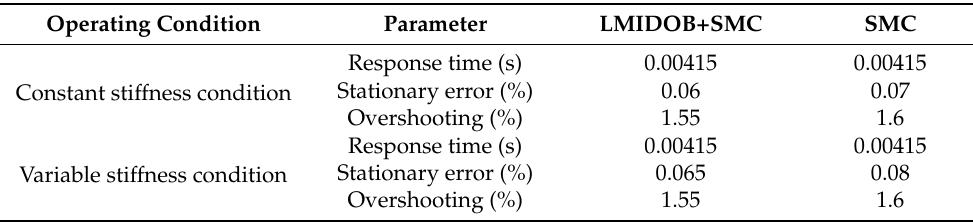
Table 2. Performance comparison of two control strategies under step